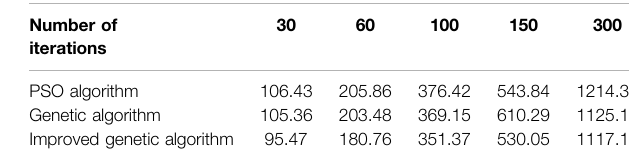
TABLE 1 | Operation time of three algorithms